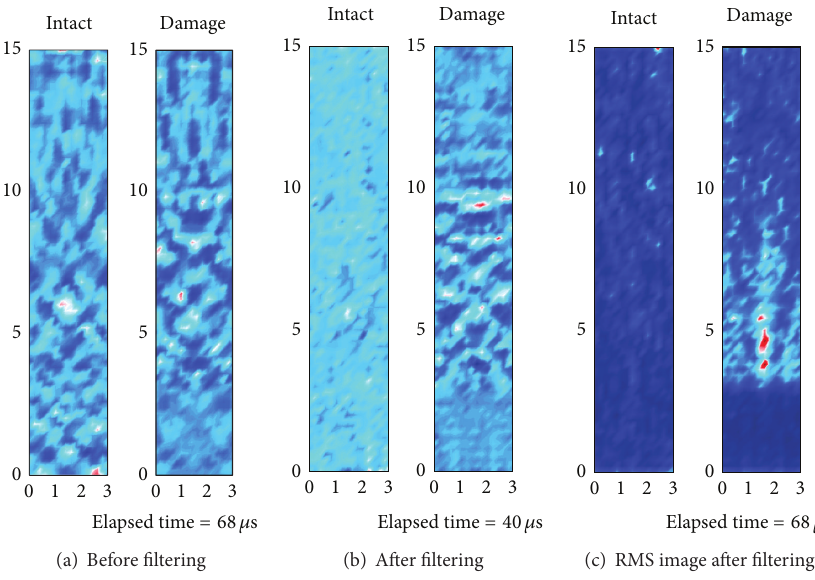
Figure 8: Visualization of the guided wave propagation and flaw